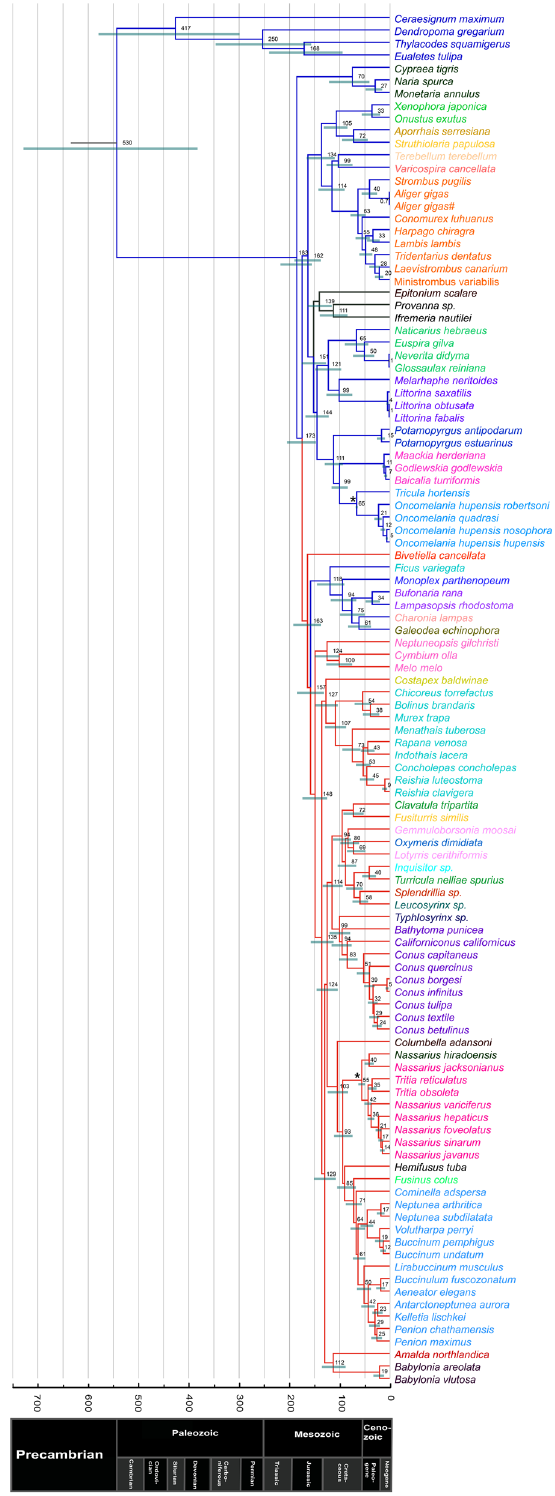
Figure 4. Estimates of divergence time inferred from Bayesian analysis of the 13 PCGs of 110 Hypsogastropoda mitogenomes. Branch colors represent classification following Bouchet & Rocroi (2005): Littorinimorpha (blue), Neogastropoda (red), outside both clades (black). Branch lengths are proportional to time (in Mya). Node values represent posterior mean ages and green bars indicate the 95% HPD. Black asterisks indicate calibrated nodes (see methods). Outgroups have been trimmed. See Table S1 for